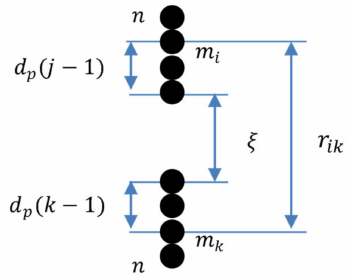
Figure 14. Illustration of the distance between centers of k -th and j -th agglomerates located in neighboring two n -agglomerate